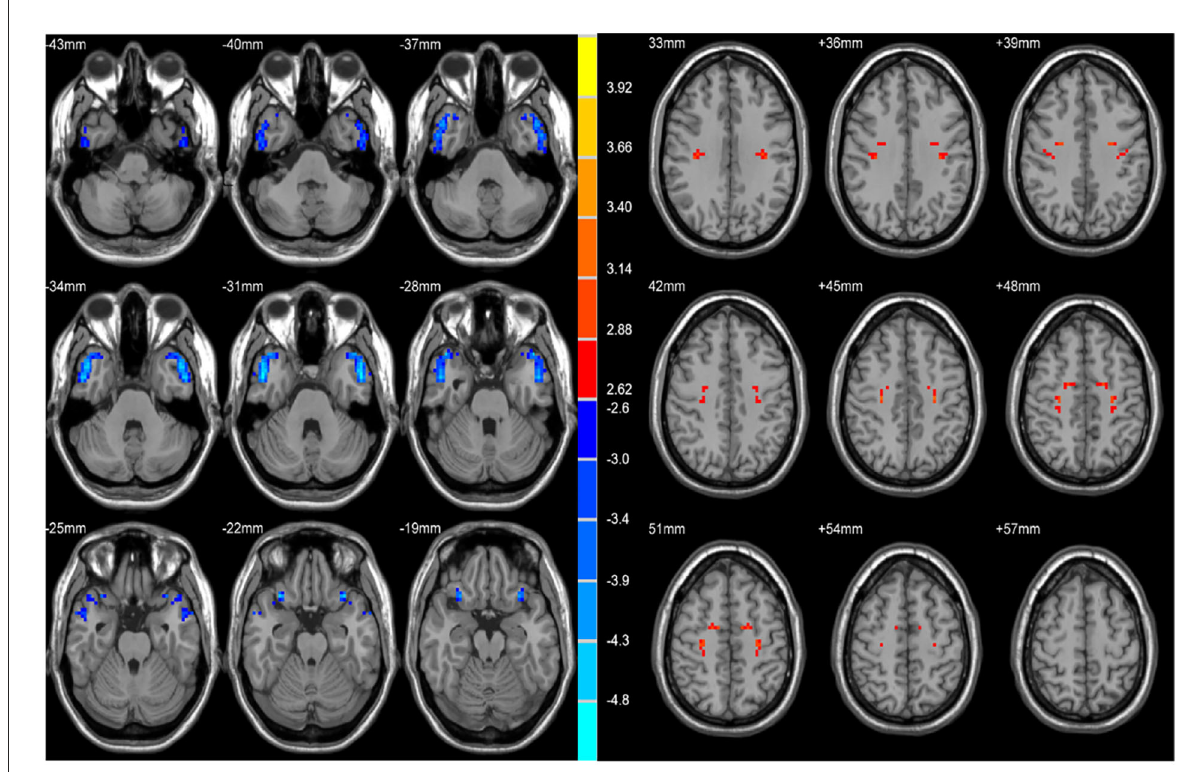
FIGURE1 Statistical maps showing VHMC differences between the subject groups. Blue denotes lower VHMC, red denotes higher VHMC, and the color bar indicates the T values from 2-sample t -tests.